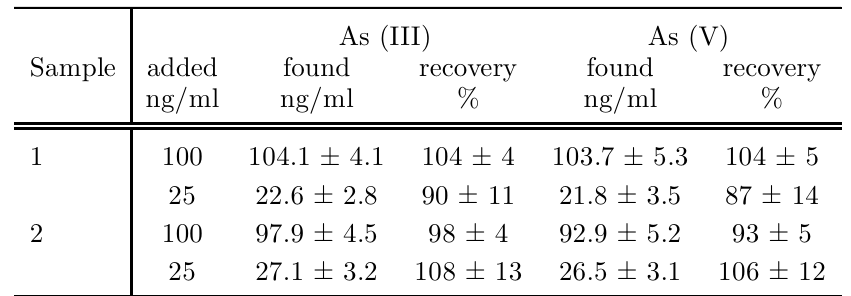
Table 3 Recovery of arsenic at the addition of standards